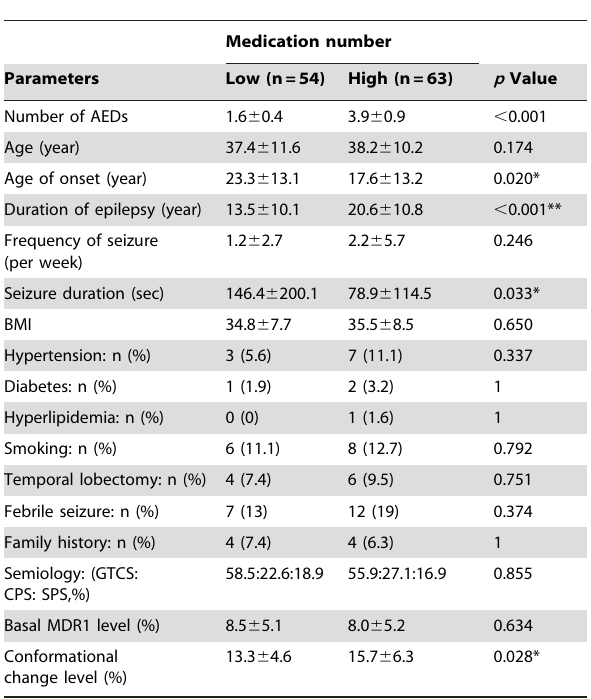
Table 5. Correlation between medication number and clinical